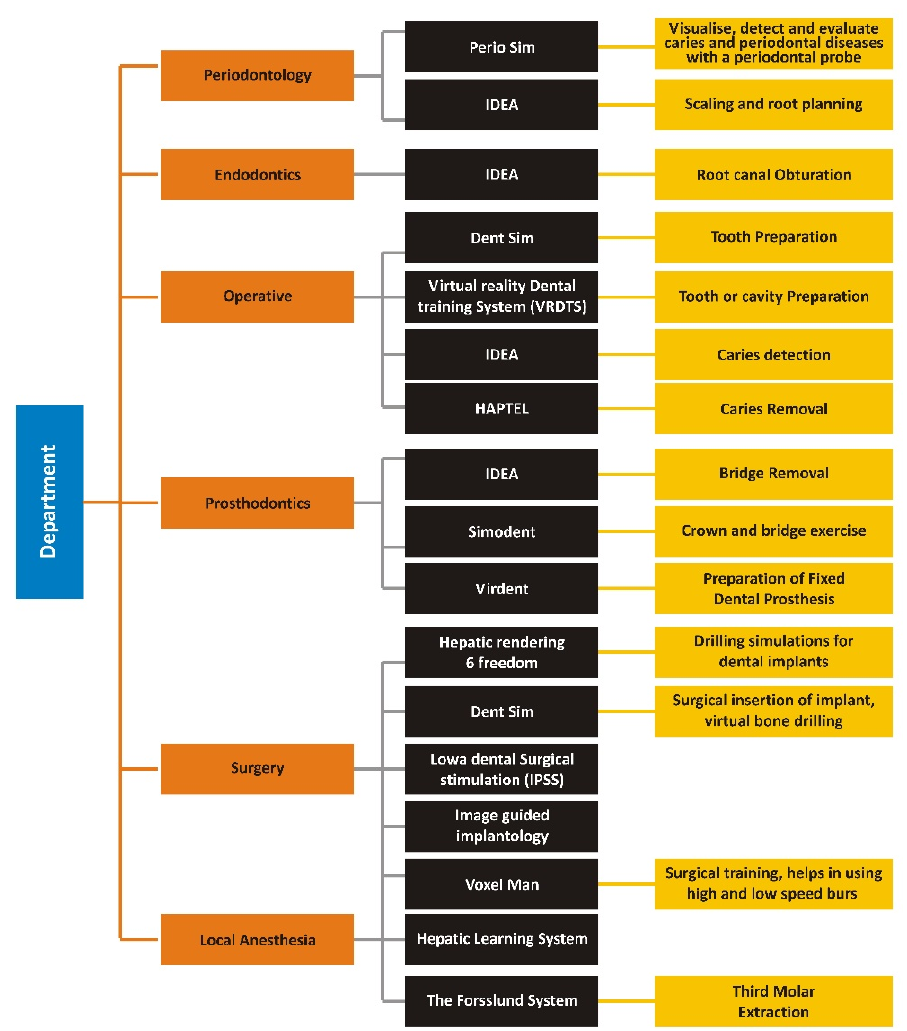
Figure 4. Classification of simulators based on their application in dental departments.